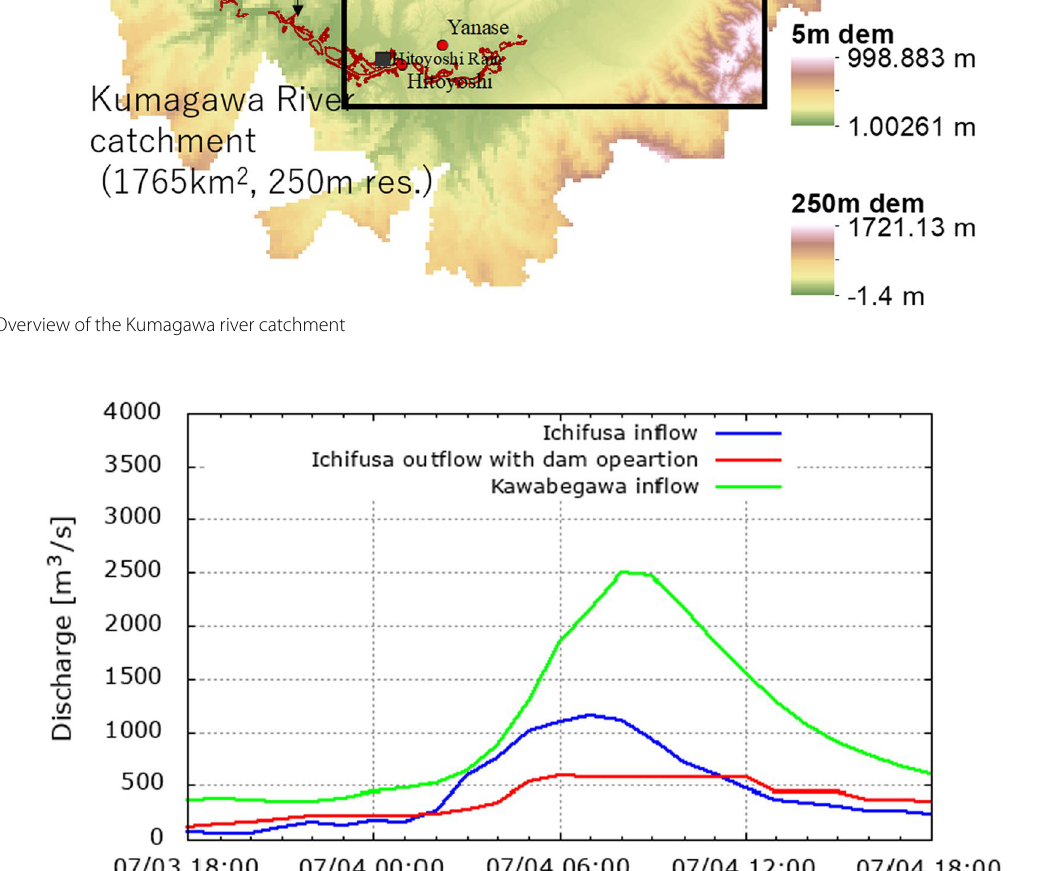
Fig. 5 Observed inflow/outflow of the Ichifusa dam and simulated inflow of assumed Kawabegawa dam by a distributed rainfall–runoff model (Sumi and Nohara